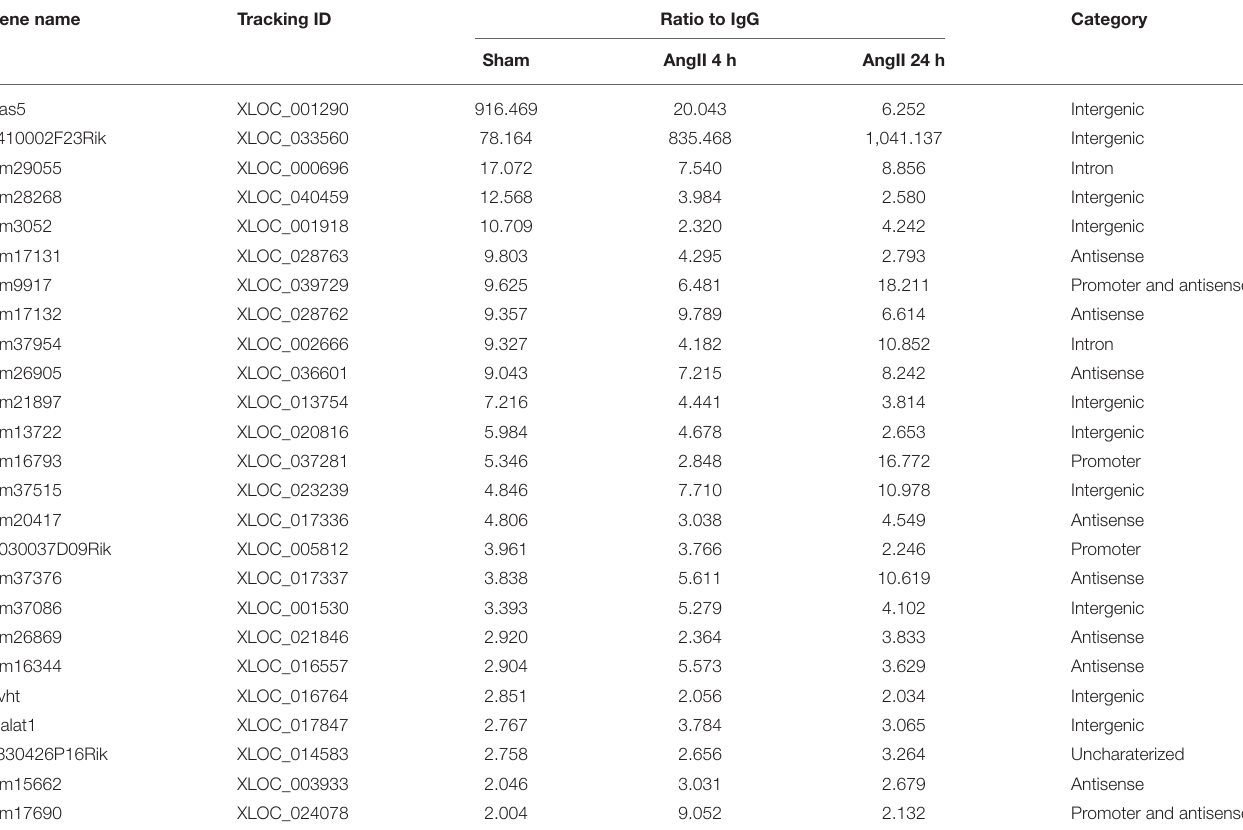
TABLE 1 | Shared EZH2-associated lncRNAs in all